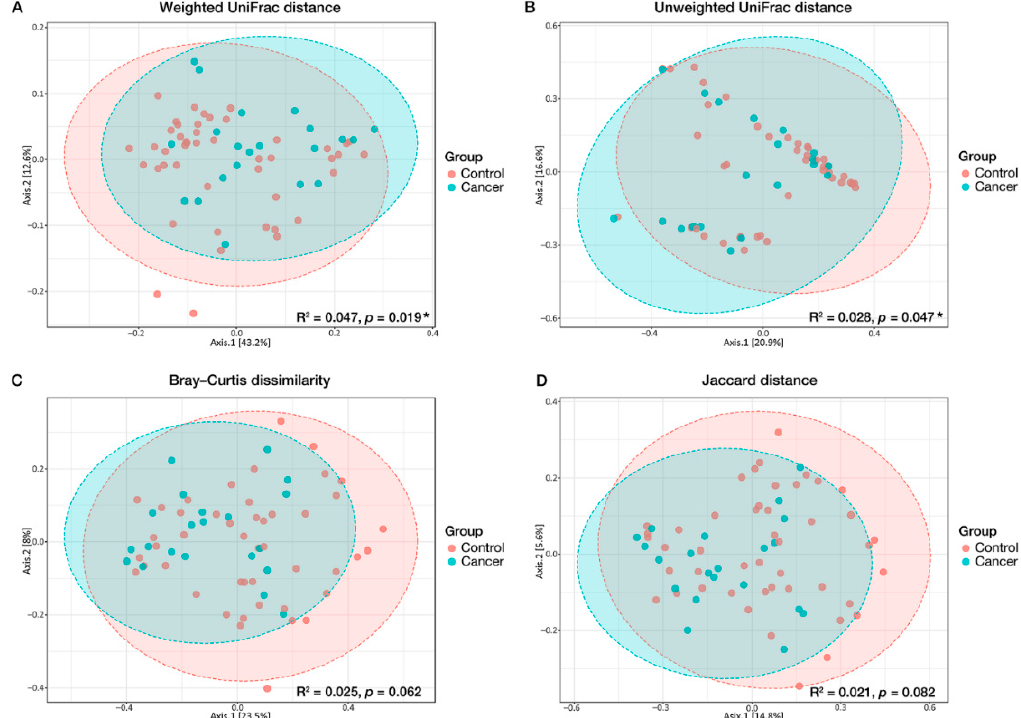
Figure 3. Different structures of the overall gastric microbiome composition ( β -diversity) between cancer and control groups in principal coordinate analysis. ( A ) Weighted UniFrac distance, ( B ) unweighted UniFrac distance, ( C ) Bray–Curtis dissimilarity, and ( D ) Jaccard distance. The effect size and significance were assessed using permutation multivariate analysis of variance. Ellipses were drawn based on the 95% confidence interval for each group. * p < 0.05.